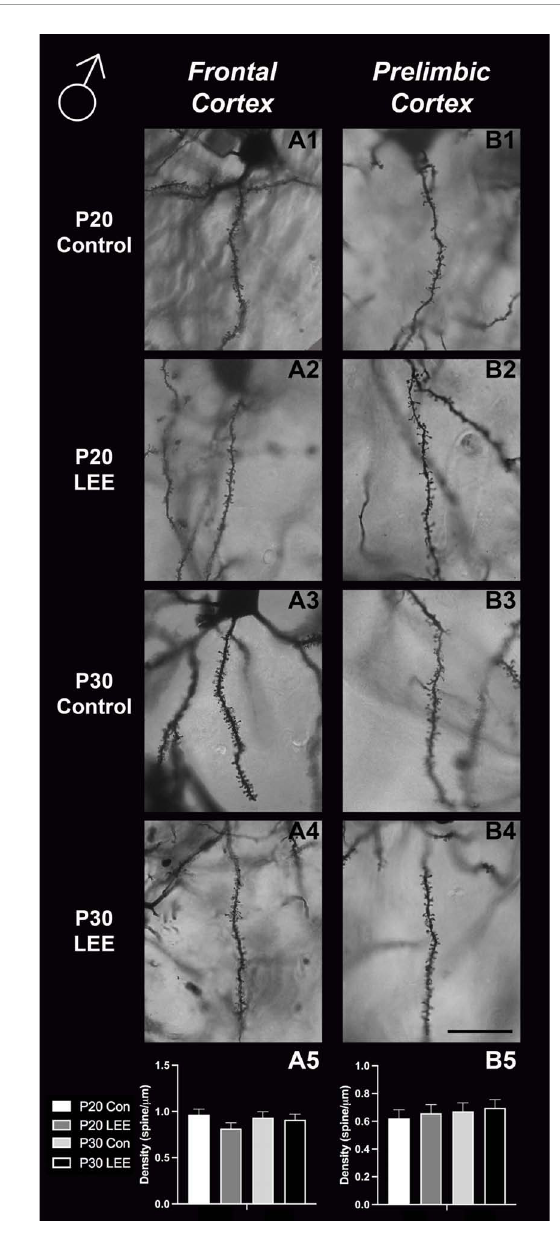
FIGURE8 Dendritic spine density – males. Representative images of secondary dendrites of pyramidal cells in layers 4/5 of the frontal and prelimbic cortices of male control (A1,B1,A3,B3) and LEE (A2,B2,A4,B4) pups at P20 and P30. Comparison of dendritic spine density of males indicated no significant differences in frontal ( A5 ; N = 14) and prelimbic ( B5 ; N = 16) cortices. Data expressed as mean ± SEM. Scale bar, 250 µ m.